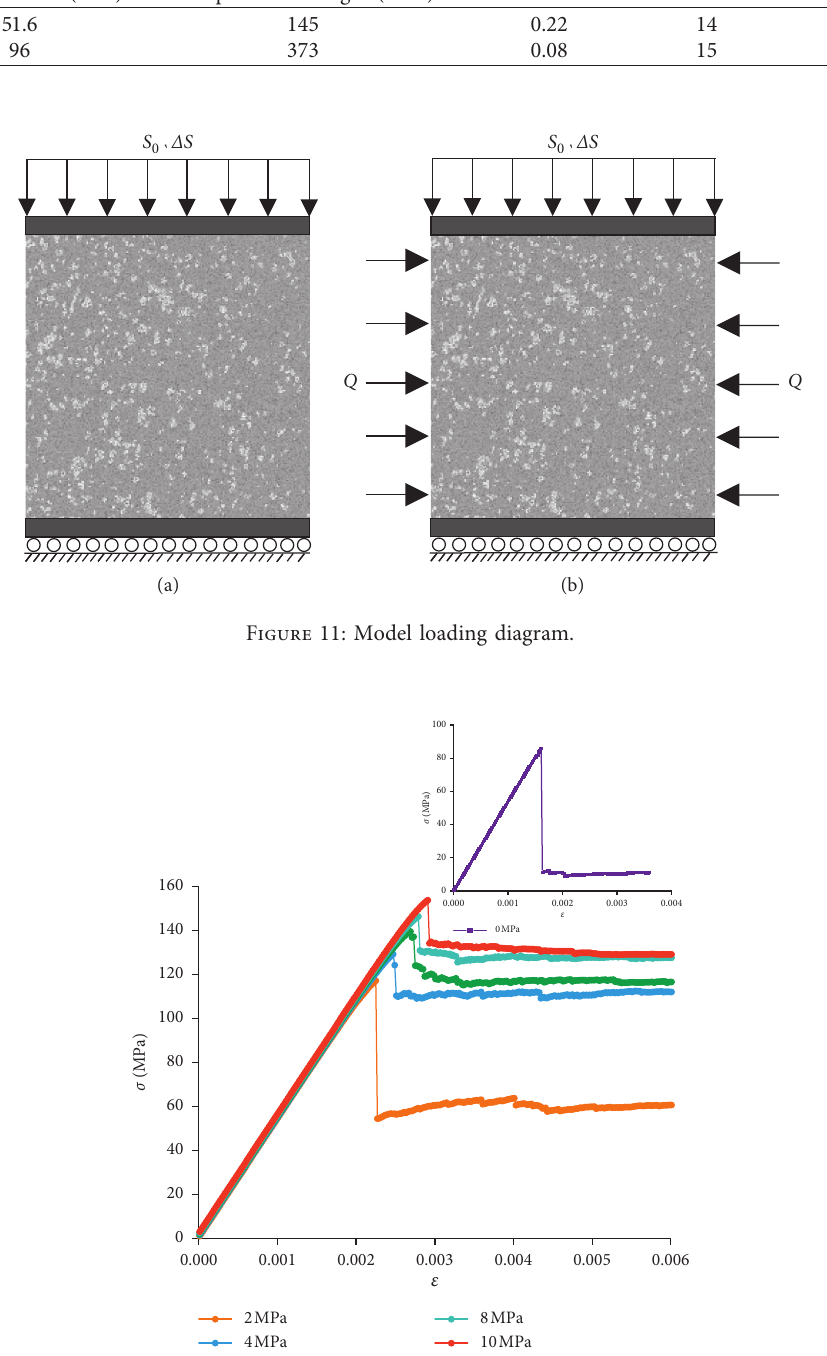
Figure 12: Stress-strain curves under different confining